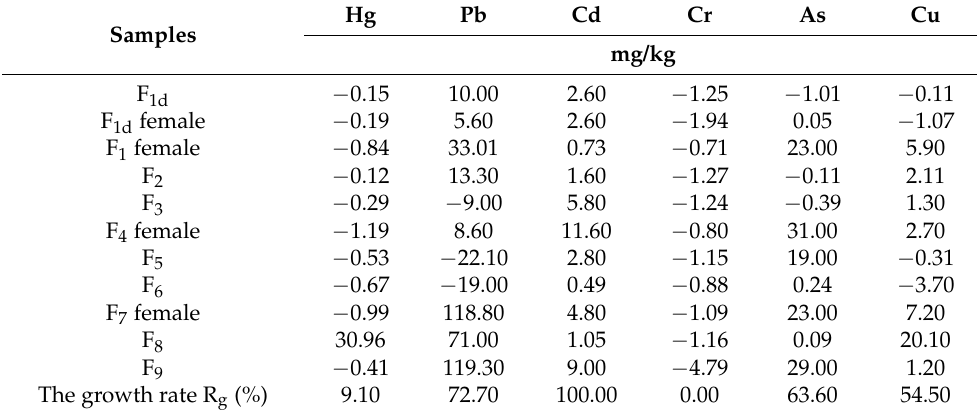
Table 7. The variation of toxic trace elements in human hair from 2015 to